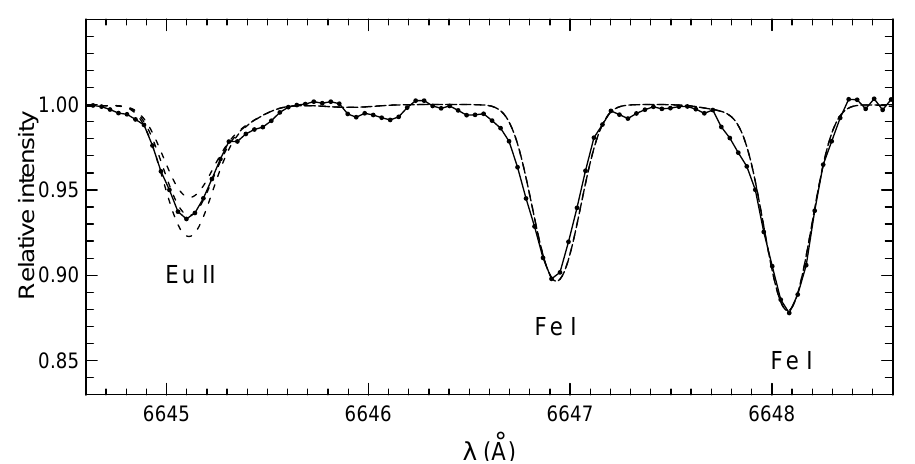
Fig. 6. Synthetic spectrum fit to the Eu ii line at 6645.10 ˚A for (cid:21) And. The observed spectrum is shown as the solid line joining the dots. The dashed lines denote the synthetic spectra with [Eu = Fe] = 0.28, 0.38 and 0.48 dex